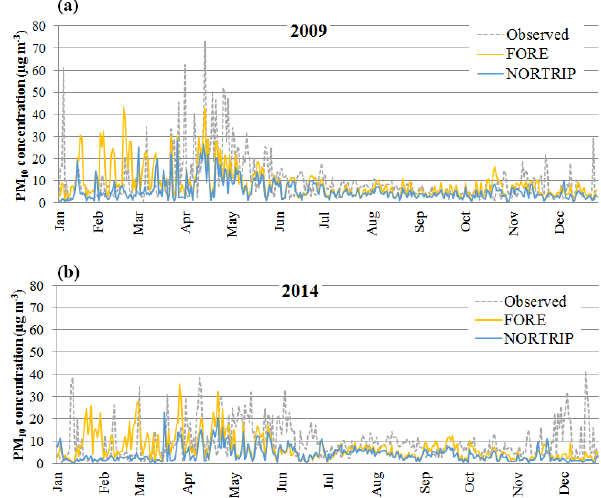
Figure 4. Time series of daily mean observed and modelled street increments of PM 10 for Hämeentie for 2009 (a) and 2014 (b)